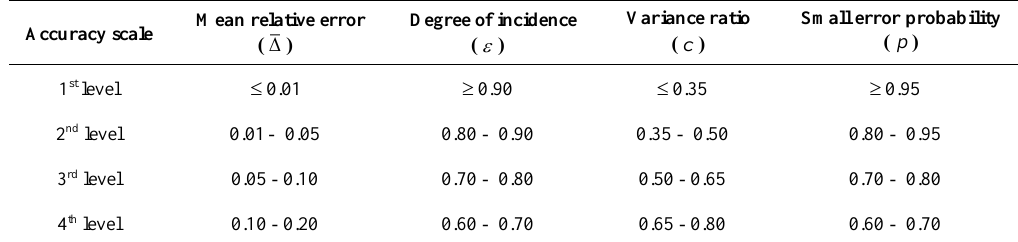
Table 1. Scales of accuracy for model testing.